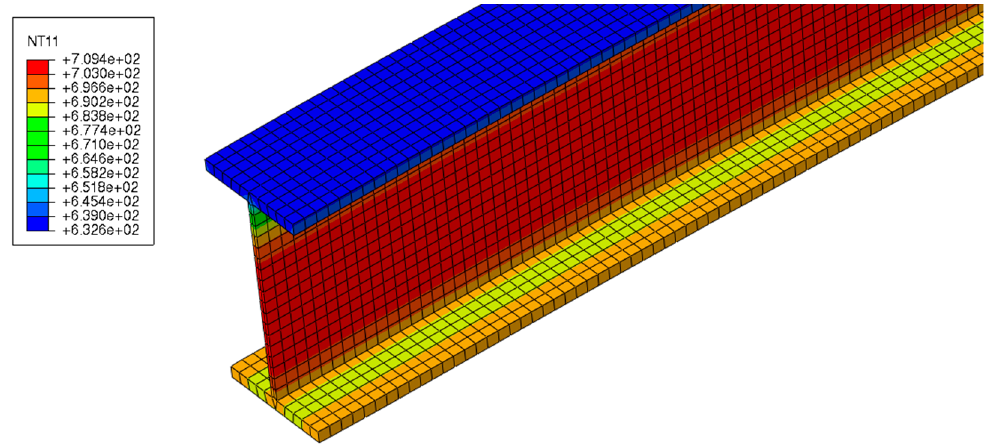
Figure 10. Temperatures distribution at t = 900 secs.